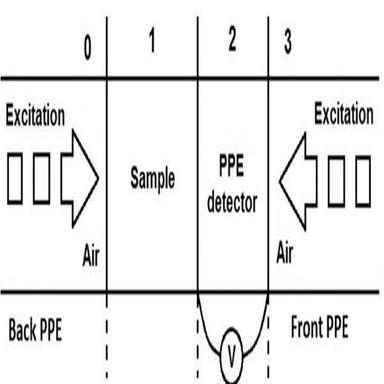
Model of the experimental cell in the back and front PPE detection configurations.